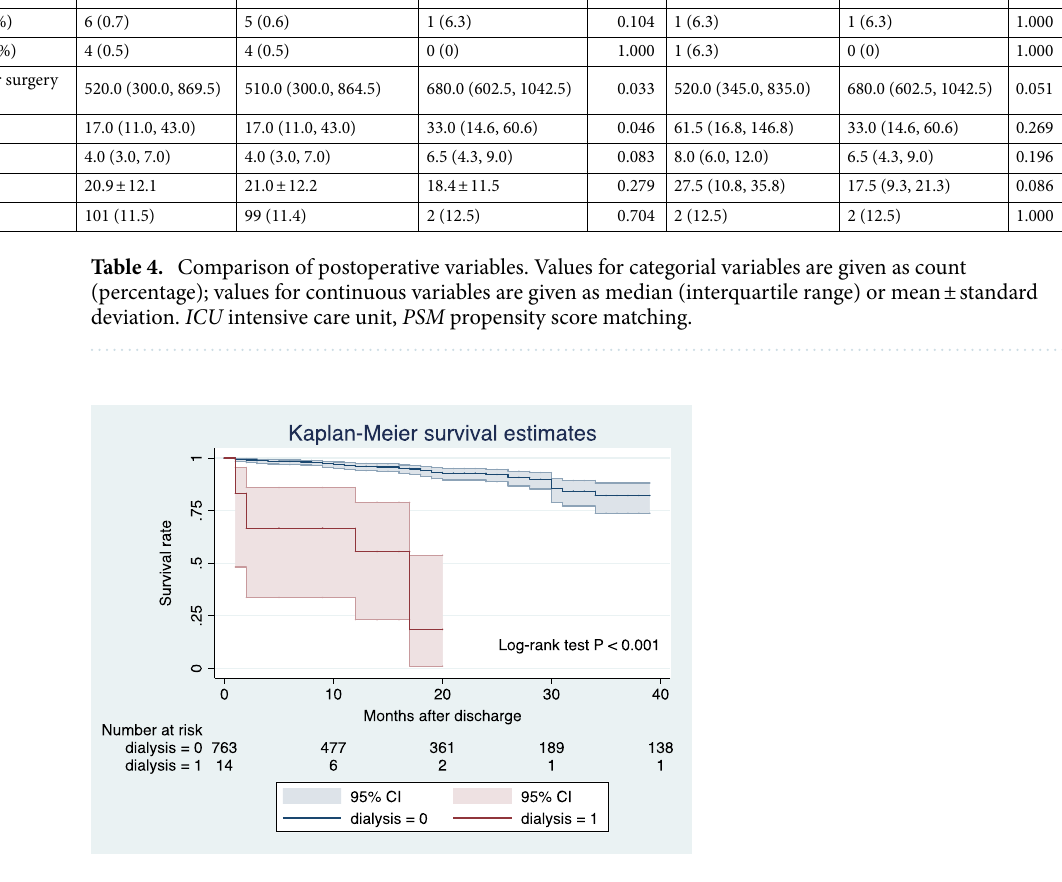
Figure 1. Kaplan–Meier curves for overall cumulative survival of dialysis and non-dialysis patients suffering from acute type A aortic